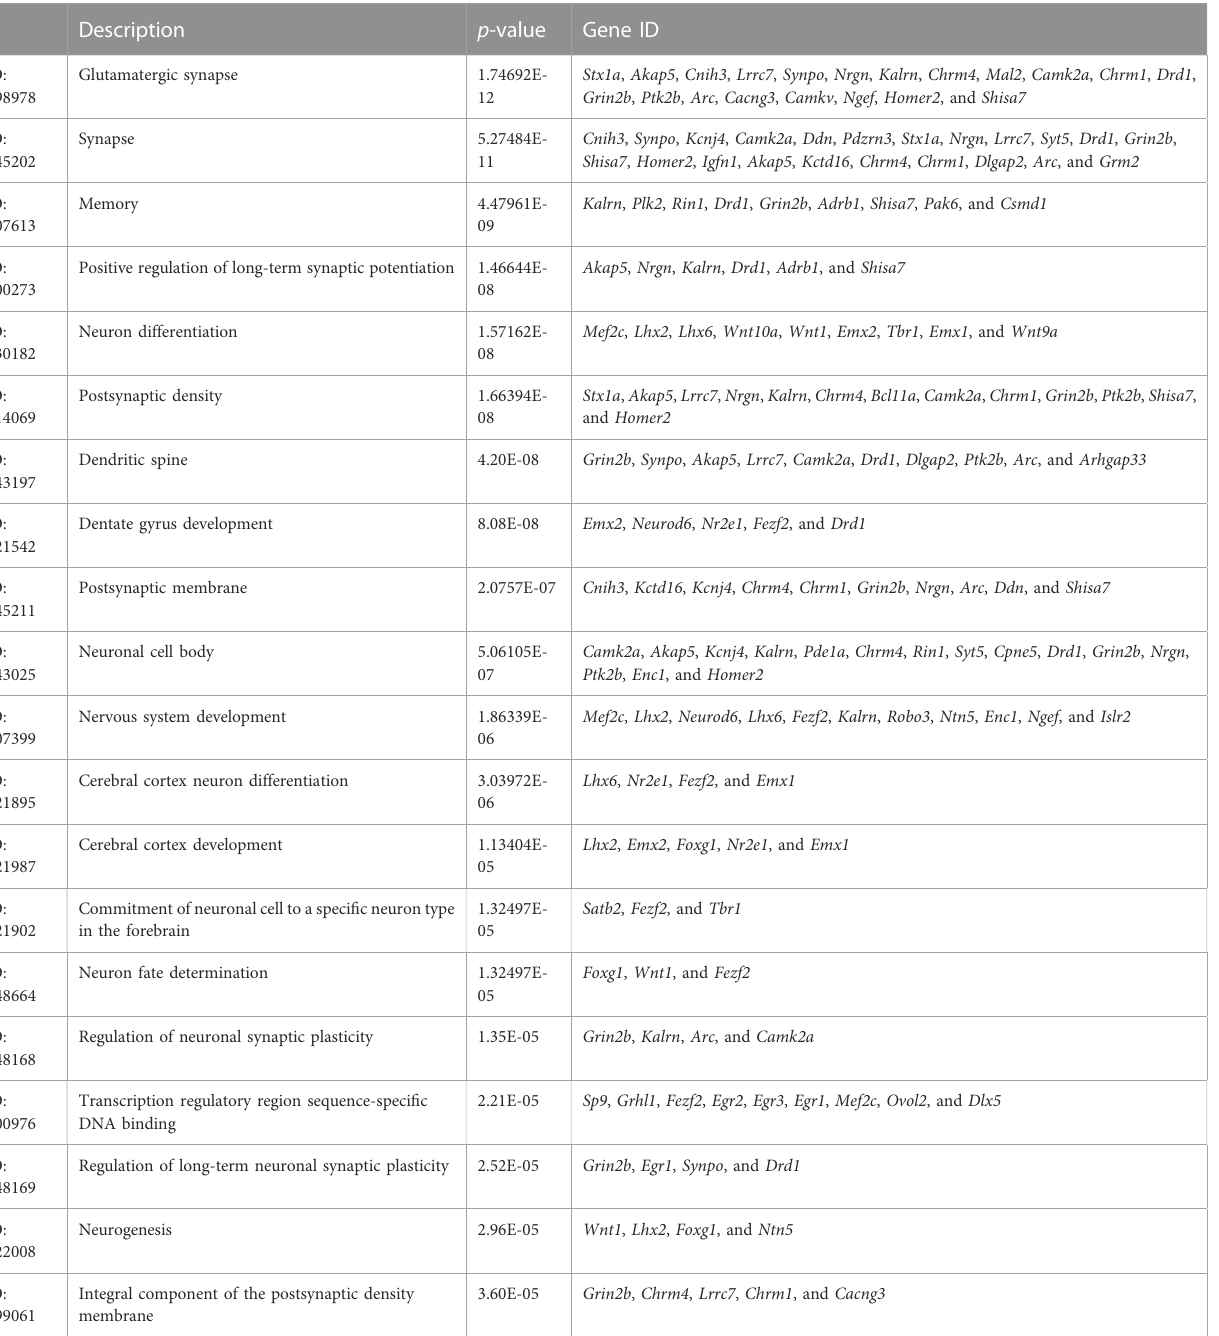
TABLE 1 Results of the GO analysis related to brain